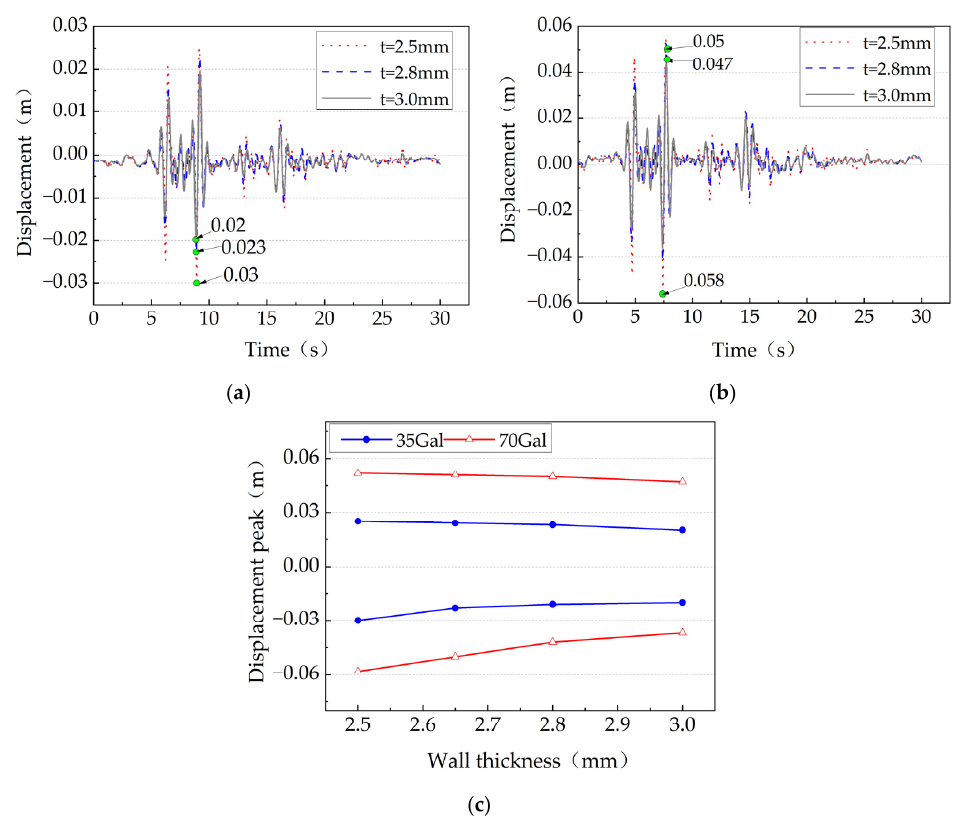
Figure 27. Displacement comparison under El Centro earthquake; ( a ) El Centro 35 Gal; ( b ) El Centro 70 Gal; ( c ) Comparison of displacement peak. Figures 28 and 29 show the changes in peak acceleration and displacement at the top of the structure under the action of the Nihonkai-Chubu earthquake and the Hyogoken- Nanbu earthquake. The influence of corrosion on the seismic dynamic response of the wind power tower in the three kinds of earthquakes all shows the law that corrosion re- duces the acceleration response of the tower and increases the displacement response of the tower. Since the steel is still in an elastic state under the action of 35 gal and 70 gal earthquakes, and the structure is not plastically damaged, the increase in the seismic peak does not make the displacement response of the structure significantly different. How- ever, the peak acceleration of the structure has an enhancement effect when the seismic acceleration becomes larger, especially for the noncorrosive structure, the change in the structural response caused by the change in the seismic peak acceleration is greater. It can be inferred that the wind power tower structure with large rigidity is more sensitive to the change of seismic peak value, and the reduced rigidity of the corroded structure also makes the structure less sensitive to the change of seismic peak value.